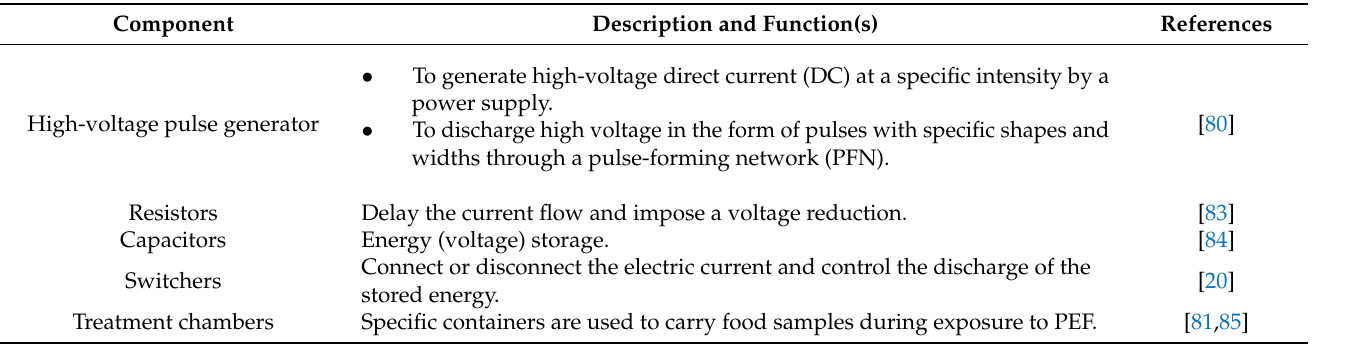
Figure 2. Schematic diagram of an electric circuit in a PEF device used for food processing. Table 2. Functions of main PEF devices